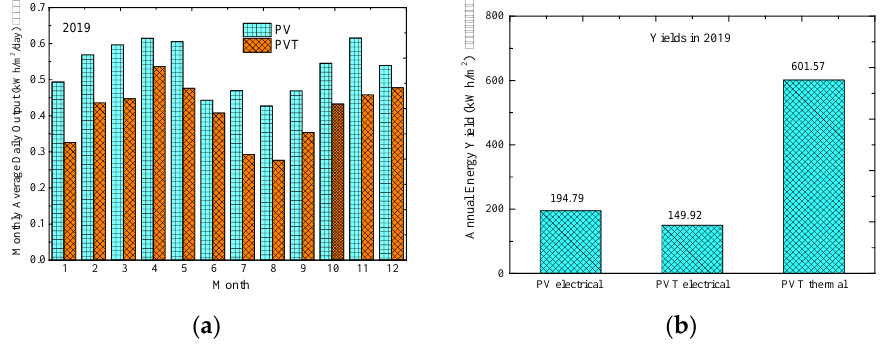
Figure 8. The energy outputs of the PV and PVT showing: (a) monthly average daily electrical energy outputs; (b) net annual energy yields.